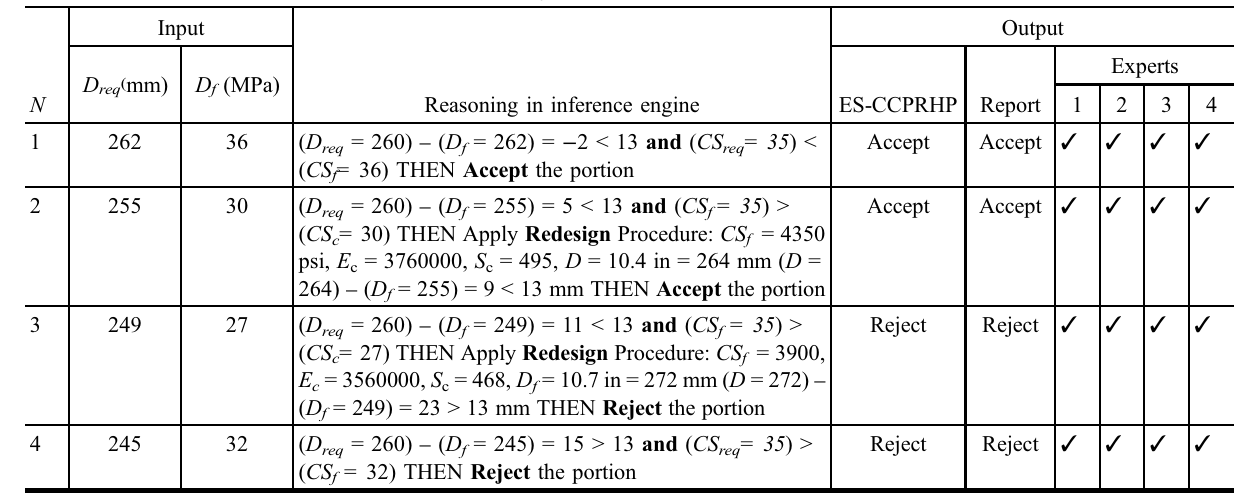
Table 8 abstracts input, inference, and output for